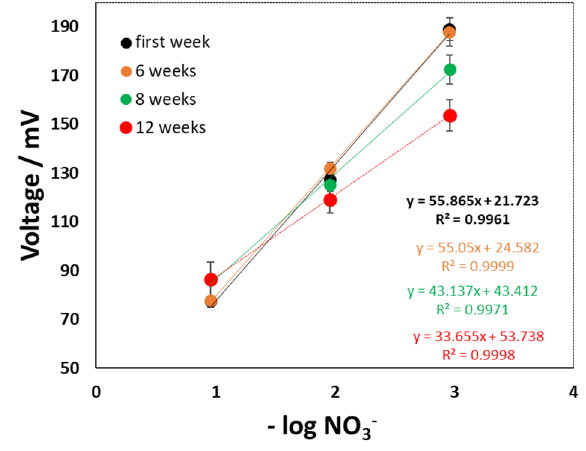
Figure 12. Calibration potential drift profile during the field trial.